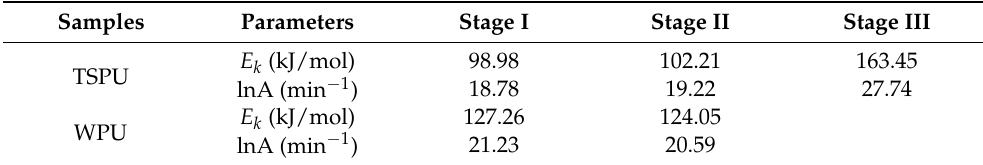
Table 2. Kinetic parameters characterizing the pyrolysis stages of PU *. Samples